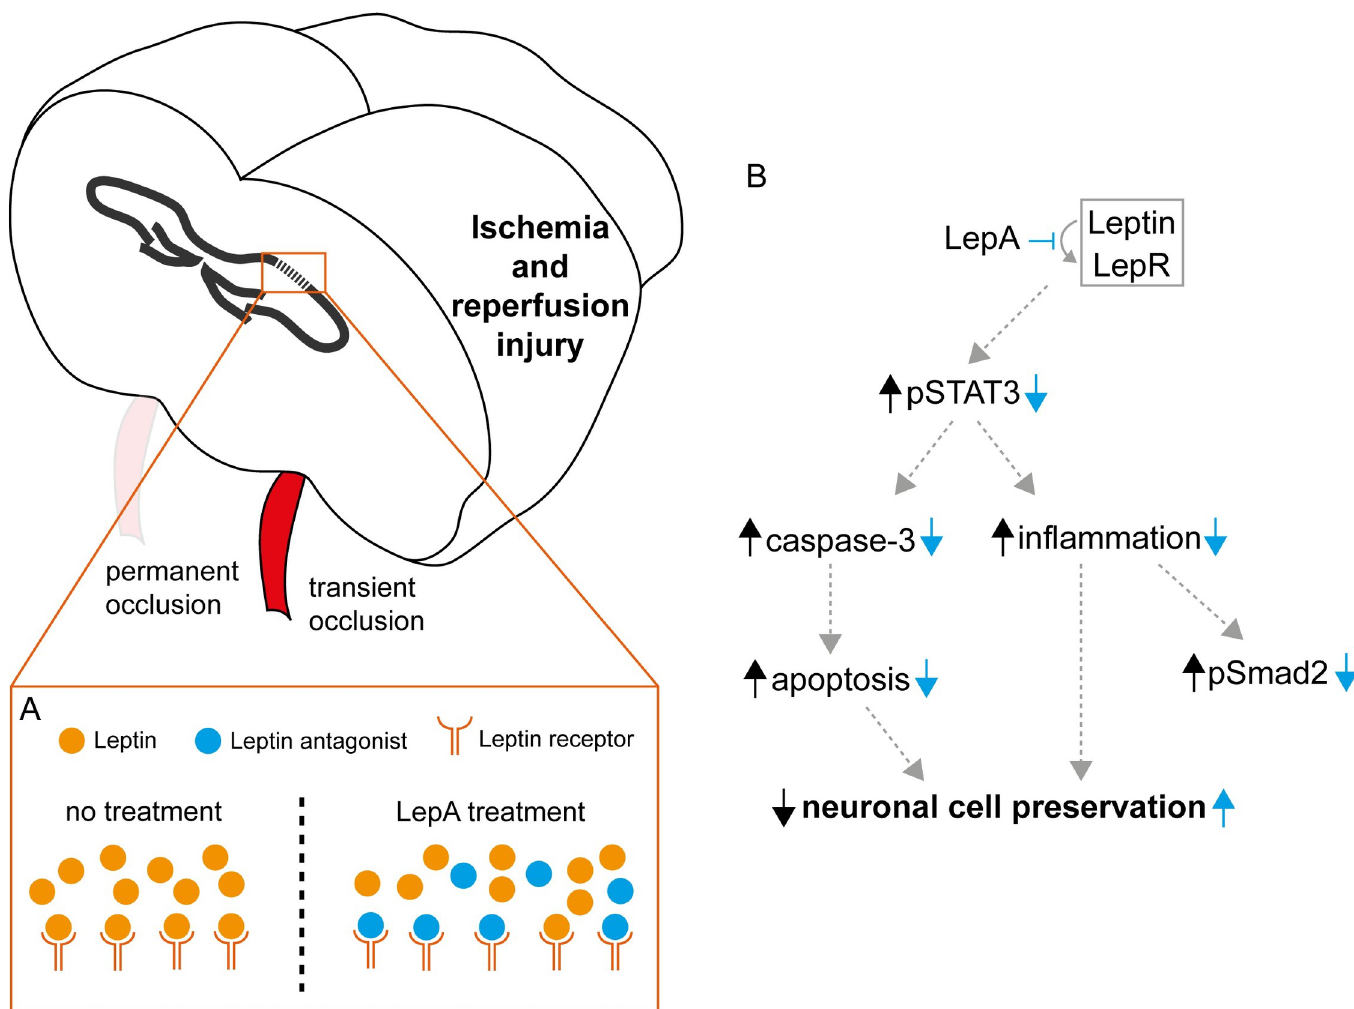
Fig 5. Schematic representation of signaling pathways pSTAT3 and pSmad2 effects in the CA1 region after IR injury, in response to LepA IA injection via ipsilateral ICA at reperfusion. ( A ) Without treatment, leptin overexpression induced by IR injury attaches to upregulated LepRs to form an active complex, while following LepA IA treatment most LepRs are occupied by LepA molecules. ( B ) Without LepA treatment the leptin-LepR complex (black arrows) induces pSTAT3 upregulation and subsequent caspase3 expression (apoptosis) and inflammation. The outcome of this cascade is increased cell death. However, LepA treatment (blue arrows), prevents leptin-LepR complex formation, resulting in reduced pSTAT3, caspase3, and inflammation. Subsequently, the outcome of LepA treatment at reperfusion is neuronal cell preservation.